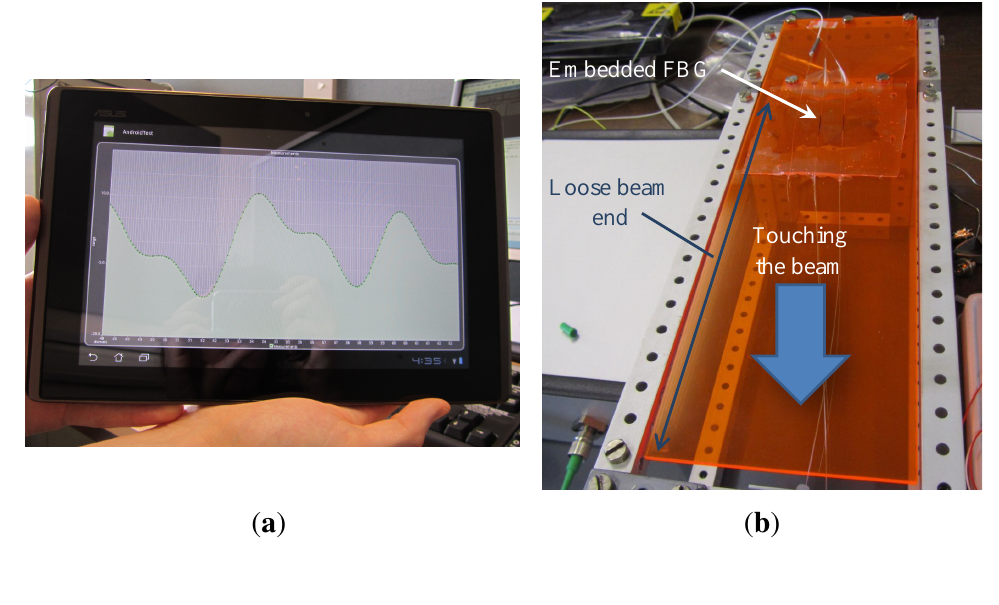
Figure 6. Proof of concept characterization set-up. ( a ) Android read-out system; ( b ) Beam test set-up with one end free to